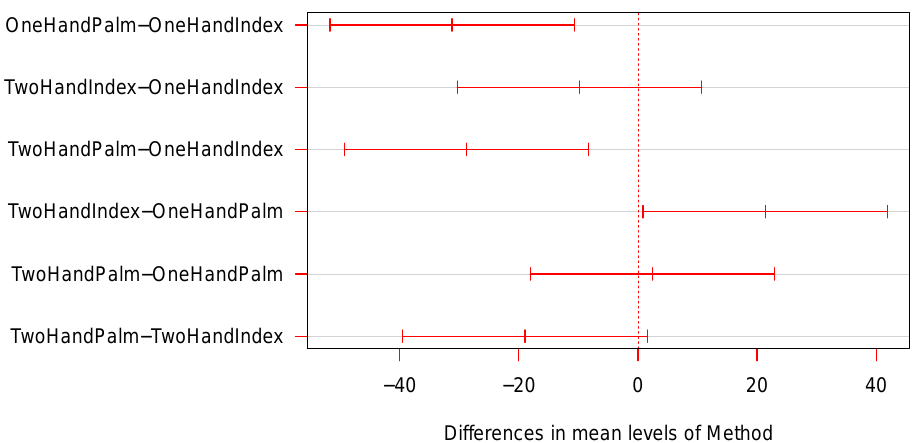
Figure 9. Results of the post hoc analysis regarding task completion